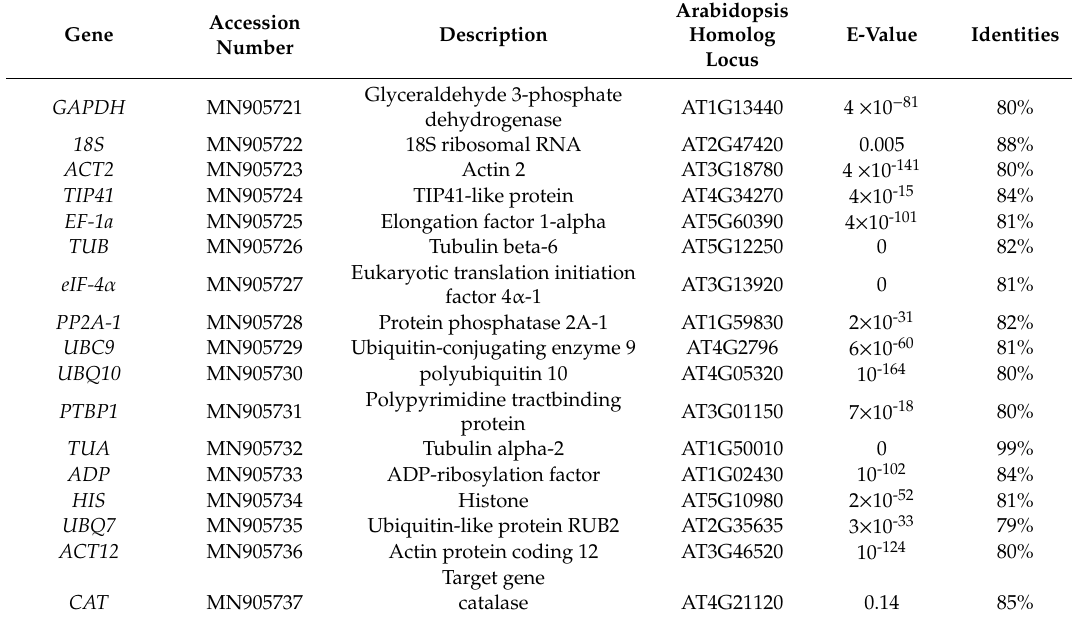
Table 1. Selected candidate reference genes used in quantitative real-time polymerase chain reaction (qRT-PCR) analysis, with information on their Arabidopsis